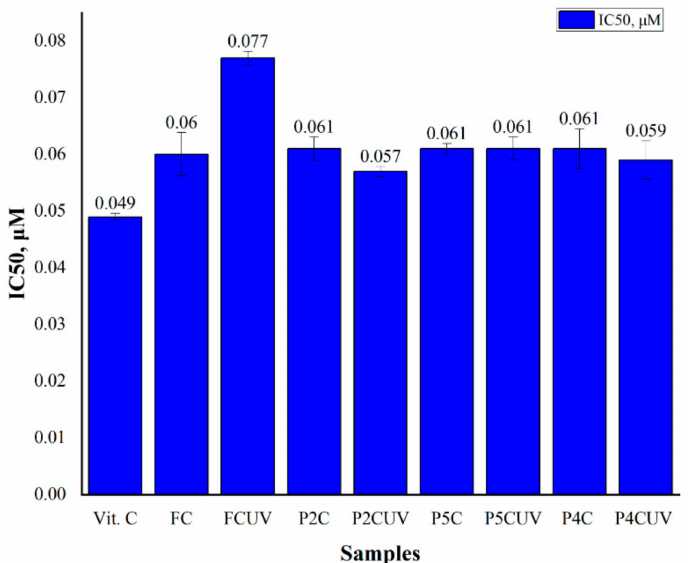
Figure 10. IC 50 values on DPPH radical scavenging assay for free curcumin (FC) and curcumin extracted from P2C, P4C, and P5C samples before and after exposure to UV light for 30 min at 365